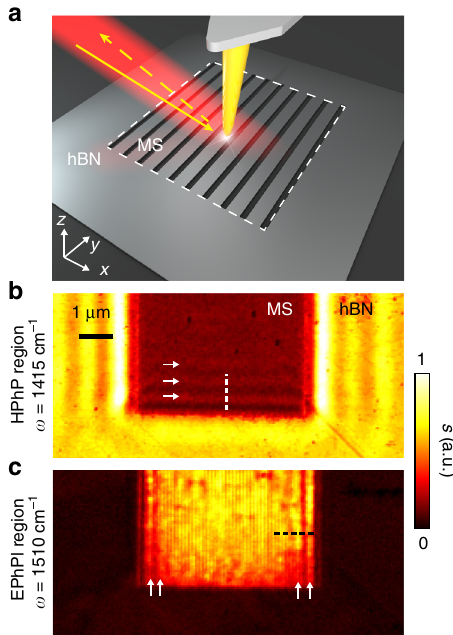
Fig. 2 Near- fi eld imaging of polariton evolution in a hBN metasurface. a Schematic of the near- fi eld nanoimaging experiment. b , c Near- fi eld images measured at two different frequencies, ω = 1415 cm − 1 (HPhP region) and ω = 1510 cm − 1 (EPhP region). White arrows indicate the polariton fringes observed on the